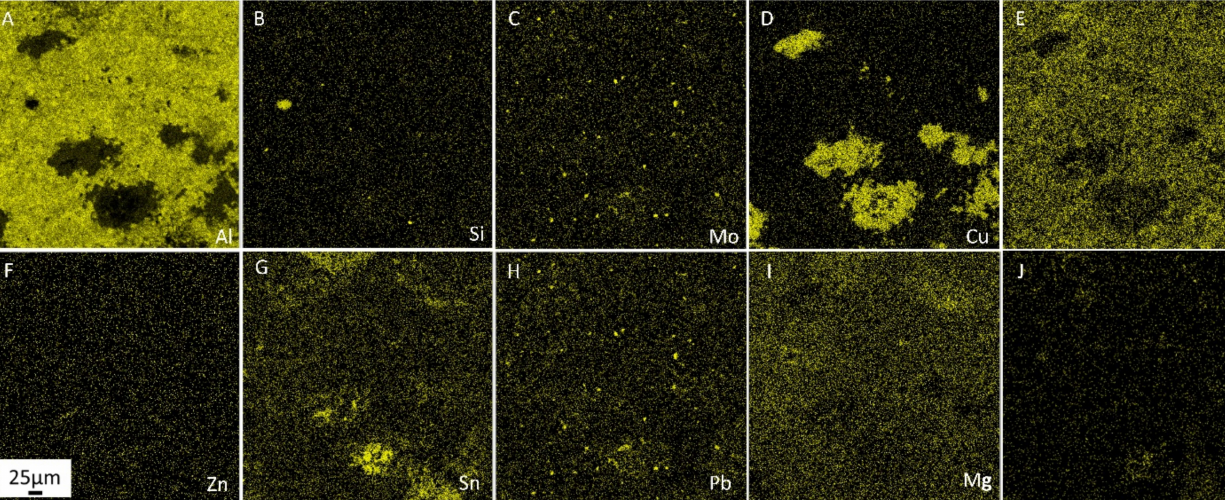
Figure 3. SEM-EDS elemental distribution maps for aluminum ( A ), silicon ( B ), molybdenum ( C ), copper ( D ), oxygen ( E ), zinc ( F ), tin ( G ), lead ( H ), magnesium ( I ) and carbon ( J ) in Al–Mo alloy. The scale in Figure F also applies to rest of images (scale: 25 µ m).